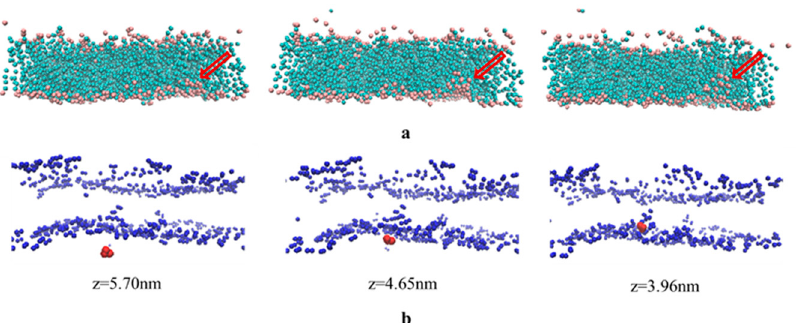
Figure 5. The observation of two process in CG MD, including transient pores formation process ( a ) and the diffusion process of 5-FU from the aqueous region into the hydrocarbon interior of stratum corneum lipids ( b ); ( a ) The aggregation of CER head groups in the bilayer center and formation of transient pores. The other components are set implicit, except for CER (pink dots for head groups and light green dots for tail groups), and the red arrow is used to indicate the position of the channel. ( b ) The diffusion of 5-FU from the aqueous region into the hydrocarbon interior of stratum corneum lipids aggregating around the CER molecule in the center of the bilayer, and the corresponding z -axis coordinates are shown underneath.